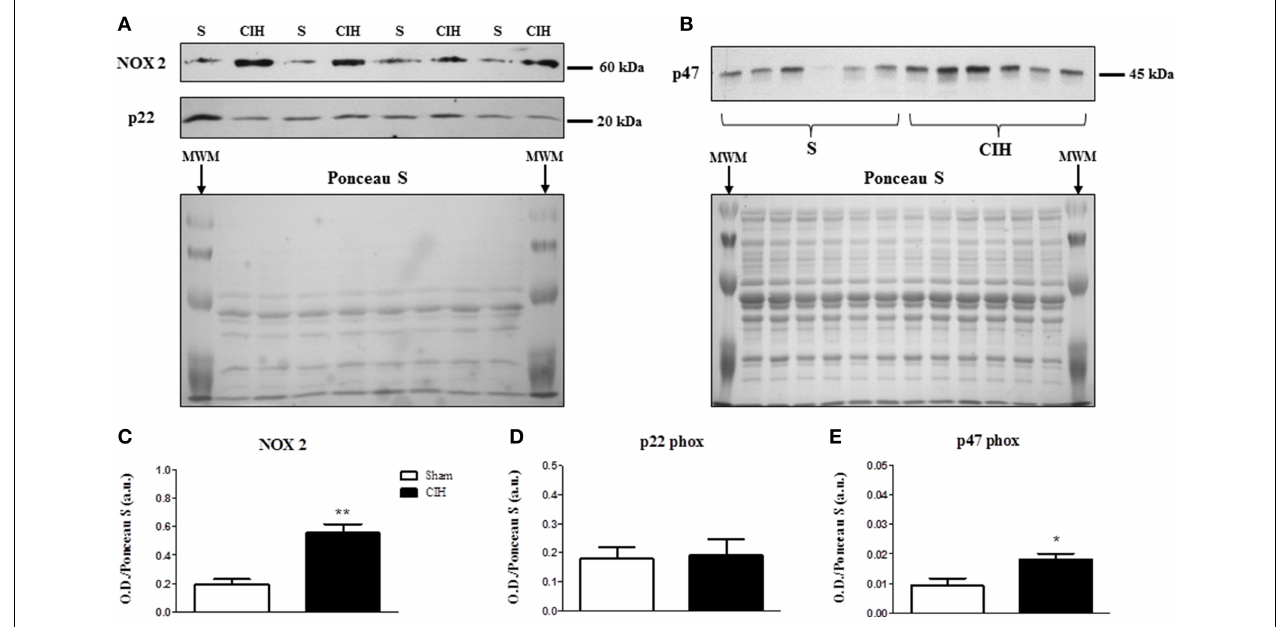
FIGURE 1 | Western blot of NOX subunit expression in the sternohyoid muscle from sham (S) and chronic intermittent hypoxia (CIH)-exposed rats. (A) Expression of the catalytic superoxide-generating NOX 2 subunit and the co-anchoring p22 phox subunit with the corresponding Ponceau S stained membrane used to normalize protein loading and electro-transfer. MWM = pre-stained molecular weight markers. (B) Expression of the organizer subunit, p47 phox with corresponding Ponceau S stained membrane. Densitometric analysis of NOX subunit band intensities normalized by